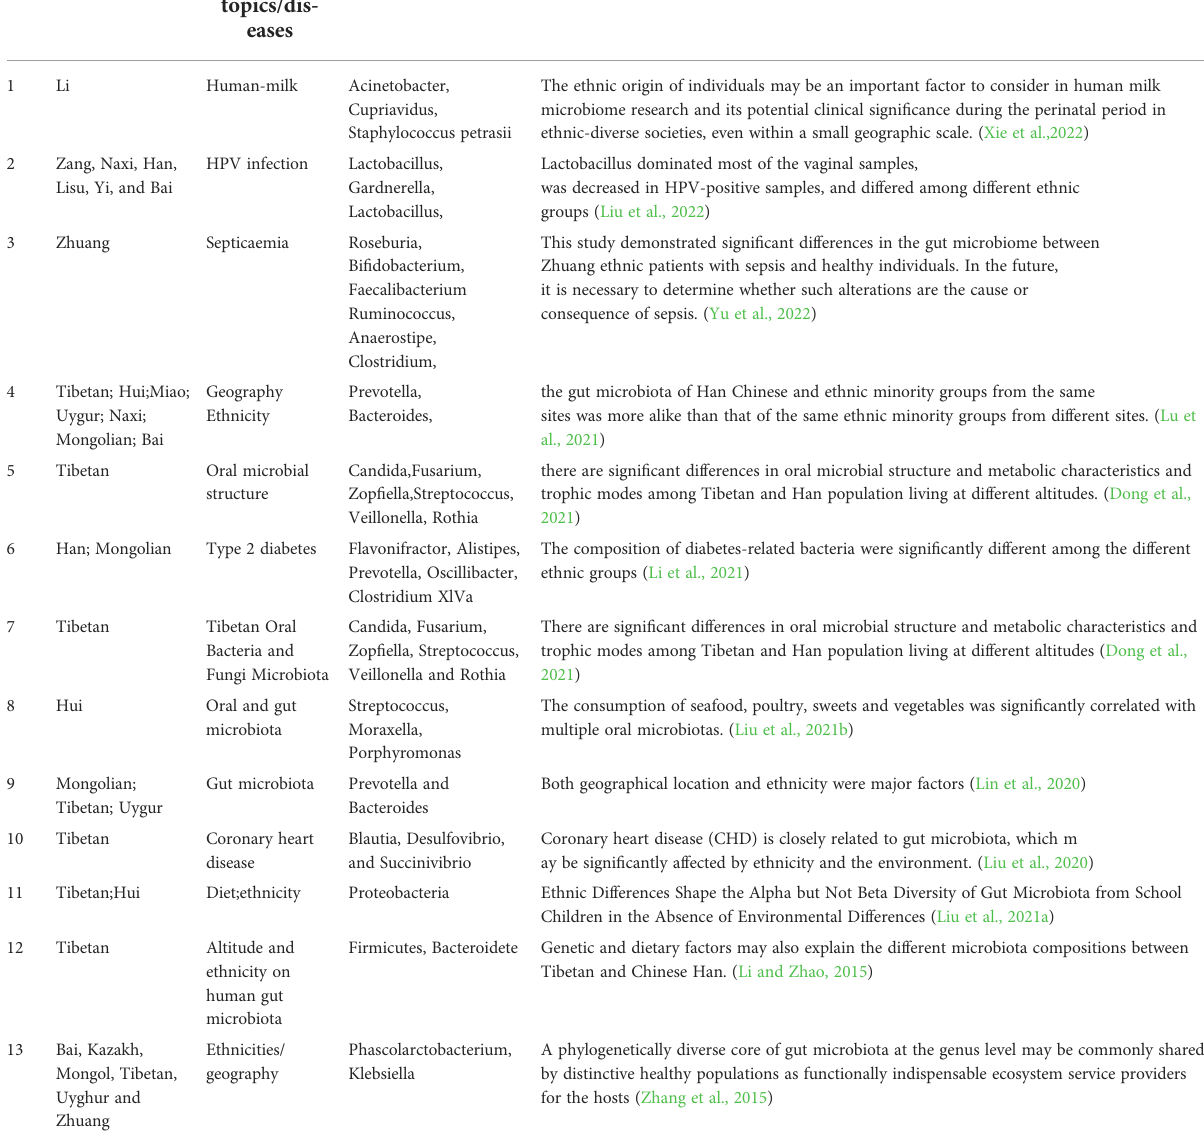
TABLE 1 A total of 13 articles about “ gut microbiota ” “ China ” “ ethnicity ” in WOS were collected.